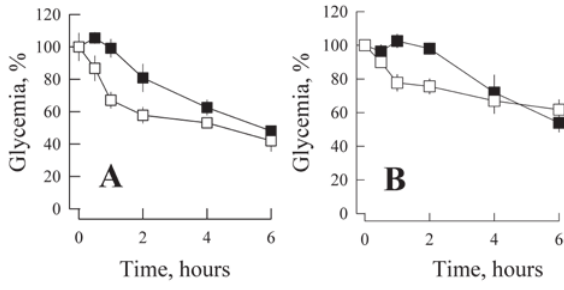
Figure 1 - Amylin induces hypoglycemia in fasting mice. Either a control solution (■, 0.9 % saline) or mouse amylin (□, 1 μg in 0.9 % saline) was administered via subcutaneous injection in 4 h-fasted mice (n = 4 per group), both A) normal (non-diabetic) and B) streptozotocin- induced type-1 diabetic mice. Glycemia was monitored using blood collected from the tail tip while the mice were fasting, conscious and unrestrained. Hypoglycemia was observed in the amylin-treated group ( p =0.008; 2h, p =0.05). Symbols represent mean ± s.e.m. Further details can be found in the Methods